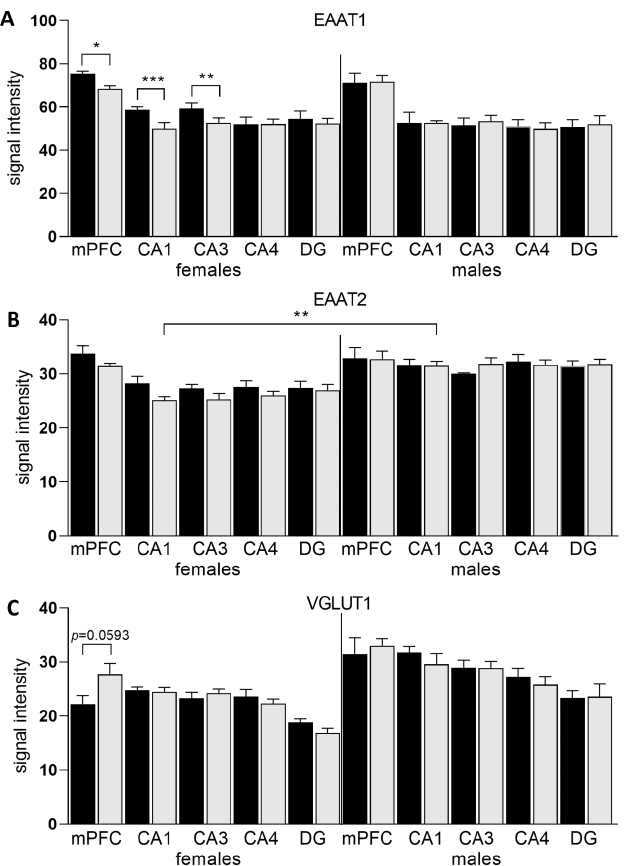
Figure 6. Intensity of immunohistofluorescence signals of EAAT1 ( A ) and EAAT2 ( B ) in astrocytes and intensity of the VGLUT1 ( C ) signal in neurons in the mPFC and hippocampal regions of female and male offspring. SCD — black bars; HSD — gray bars.* p < 0.05; ** p ≤ 0.01; *** p ≤ 0.001.